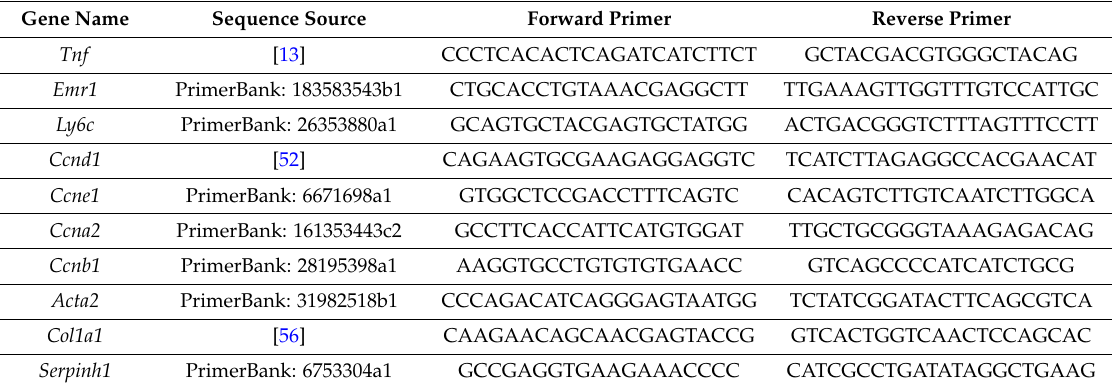
Table 2. Primers used for real-time PCR transcript